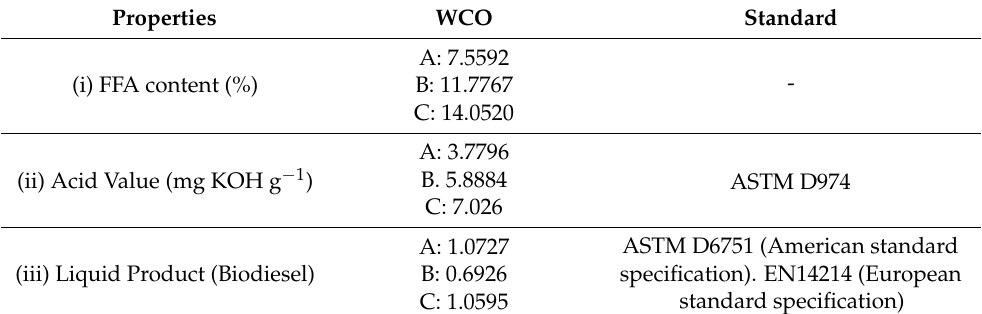
Table 2. Acid values of WCO.